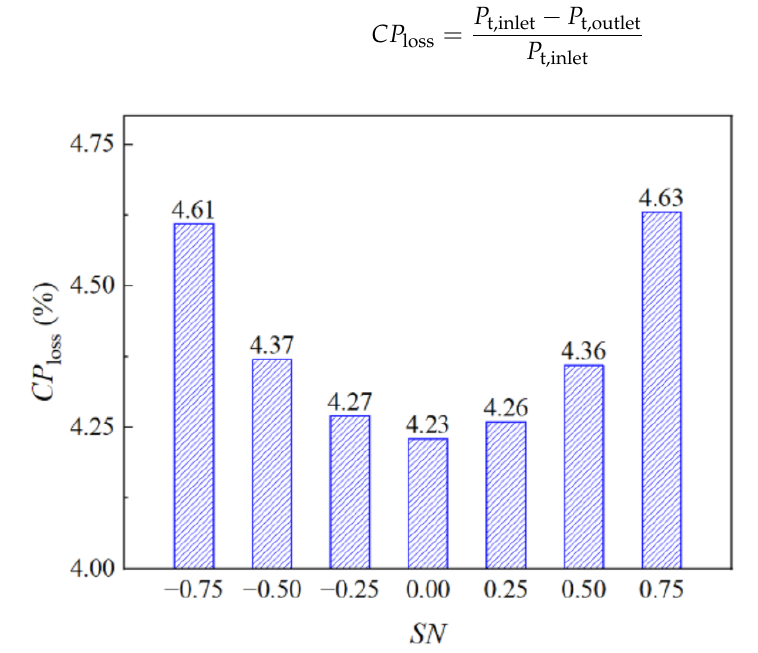
Figure 18. Total pressure loss coefficient under different swirl